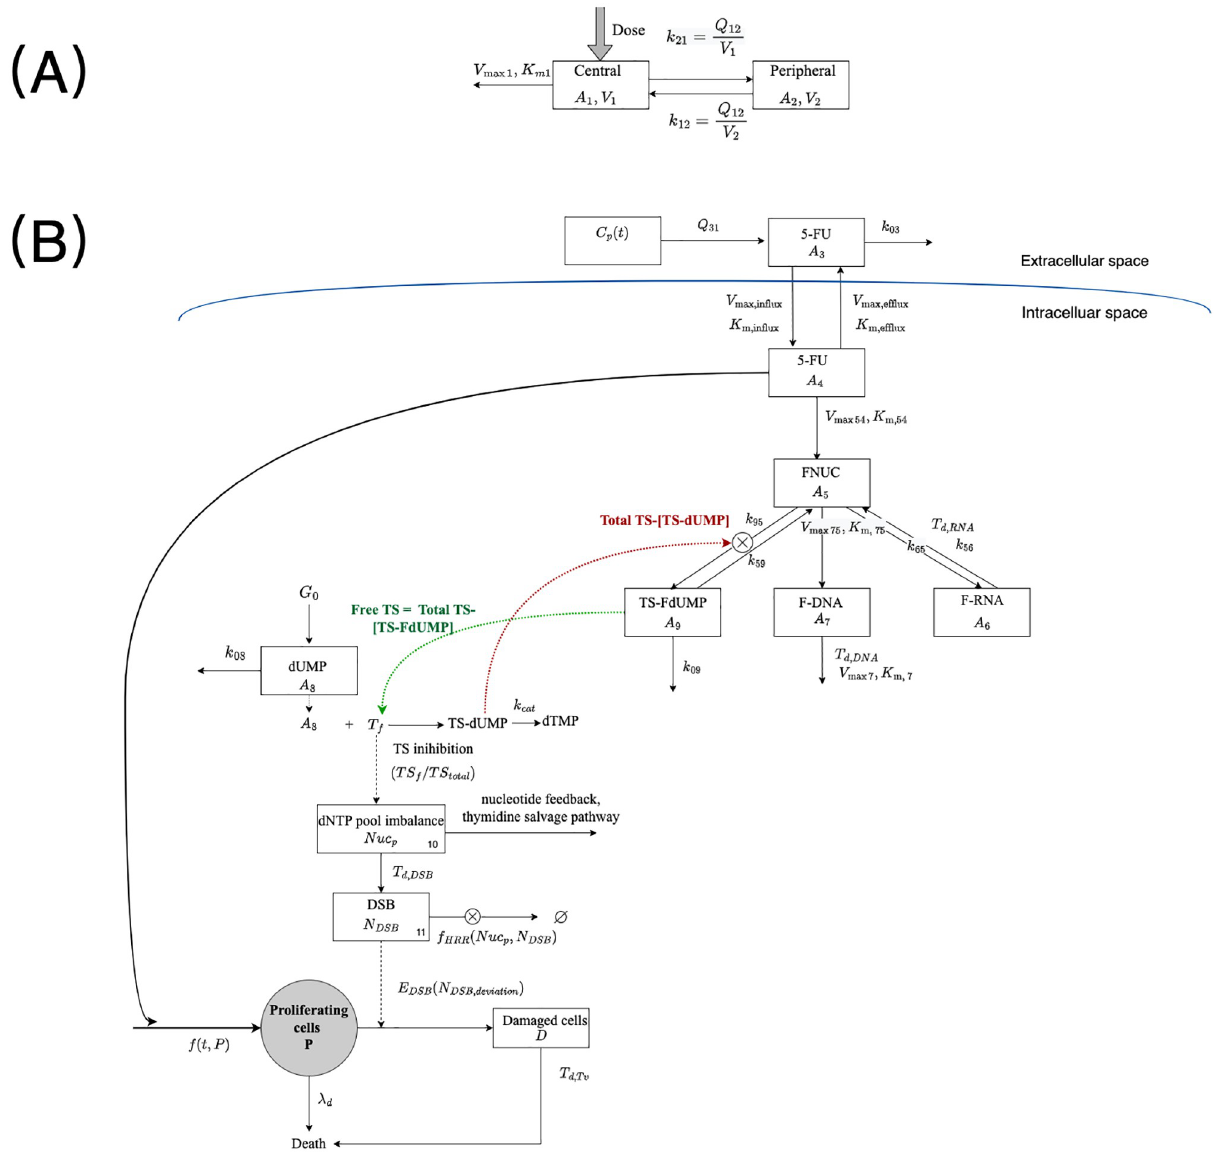
Fig 1. Schematic representation of PK, cellular and tumor growth inhibition (TGI) model. (A) PK model; (B) Cellular and TGI model. A 1 :amount of 5-FU in central plasma; A 2 : amount of 5-FU in peripheral compartment; C fluid; A 4 : amount of 5-FU in the intra-cellular domain; A 5 : amount of 5-FU anabolites; A 6 : incorporation of FUTP into RNA; A 7 : incorporation of FdUTP into DNA; A 8 : amount of dUMP; A 9 : amount of TS-FdUMP complex; TS pool imbalance; N DSB : count of 5-FU induced DSBs; N DSB , deviation : deviation of 5-FU induced DSBs from baseline; P : amount of proliferating cells; D : amount of damaged cells. V : volumes of compartments; V rate constant; T : delaying parameters; G 0 : production rate of dUMP;; λ d : death rate of tumor cells without 5-FU; f HRR : rate of repair of DSBs by HRR. E DSB : measure of contribution of DSBs in producing damaged